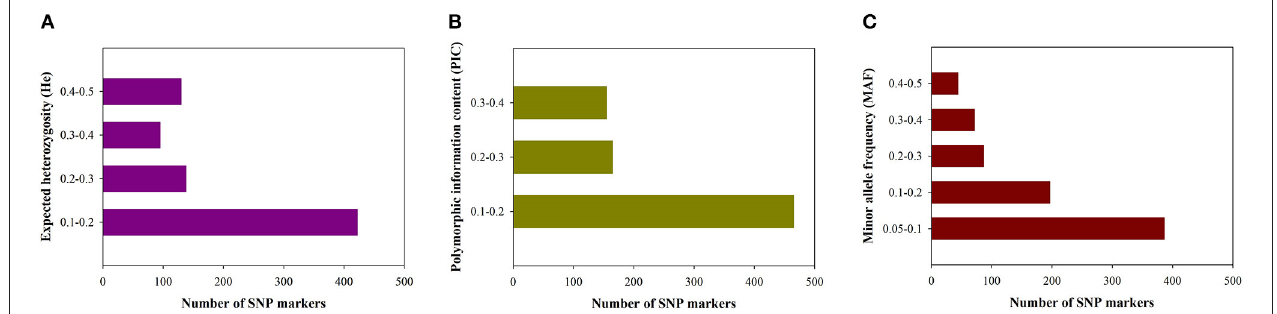
FIGURE 2 | Distribution of genetic diversity for putative single nucleotide polymorphisms (SNPs). (A) Expected heterozygosity (He). (B) Polymorphic information content (PIC). (C) Minor allele frequency (MAF).